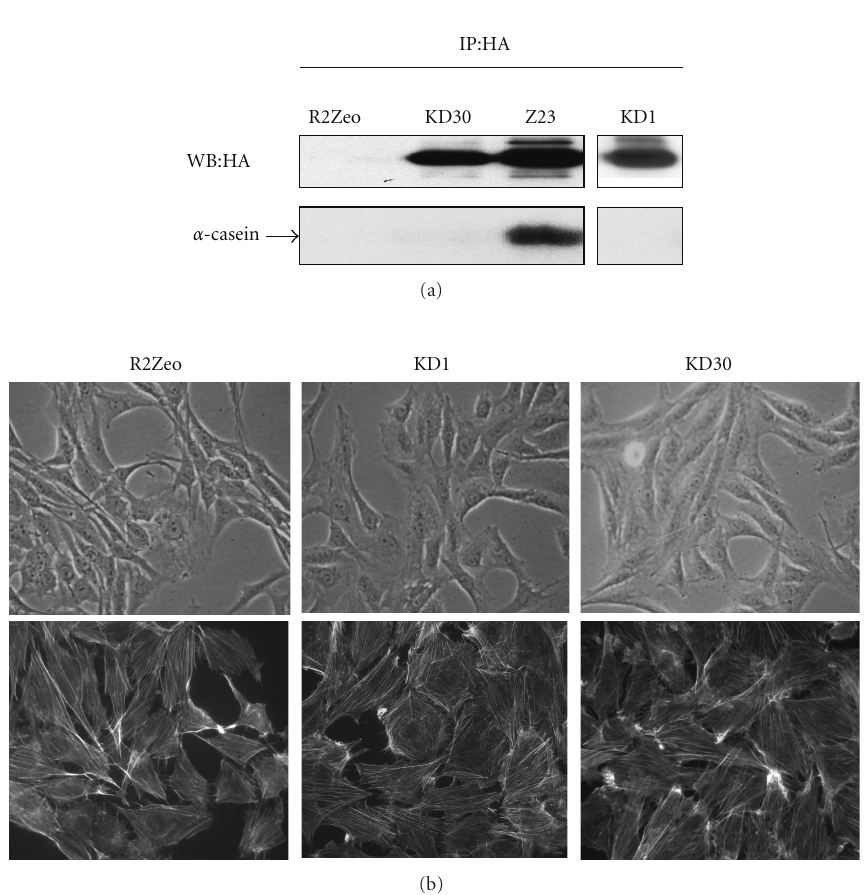
Figure 3: The catalytic activity of CKI γ 2 is required to induce change in cell morphology and actin stress fibers in fibroblasts. (a) Isolated clones of fibroblasts stably transfected with a plasmid encoding HA-tagged wild-type CKI γ 2 (Z23), HA-tagged kinase deficient CKI γ 2 (KD1 and KD30), or pool of stable fibroblasts transfected with an empty plasmid (R2Zeo) were analyzed for HA-CKI γ 2 expression by HA Western Blot (WB) on HA immunoprecipitates (IP) and CKI γ 2 activity as determined on HA immunoprecipitates from equal amounts of protein normalized cell lysates and in vitro kinase assays using α -casein as substrate. KD1 and KD30: clones that overexpress kinase deficient CKI γ 2 at the same levels as cells stably overexpressing wild-type CKI γ 2 (Z23). (b) Morphology of serum growing cells was visualized by phase contrast microscopy (40X) (upper panels) and actin organization by actin staining with rhodamine-conjugated phalloidin (63X) (lower panels).